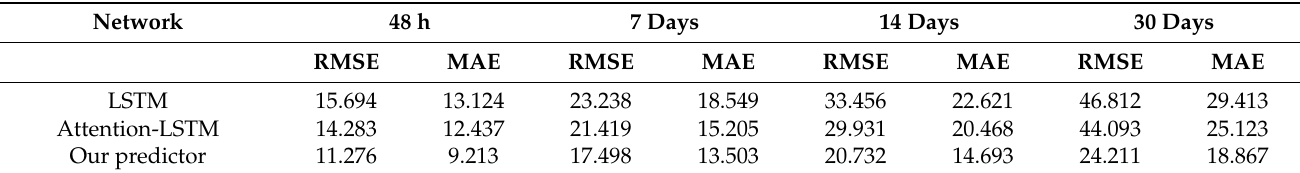
Table 3. The comparison of LSTM, Attention-LSTM and our predictor in prediction performance.